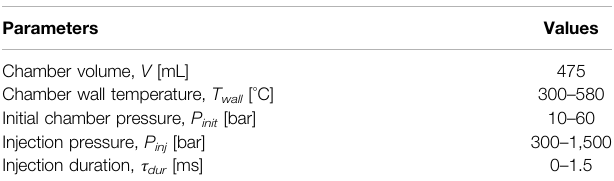
TABLE 1 | CRU basic